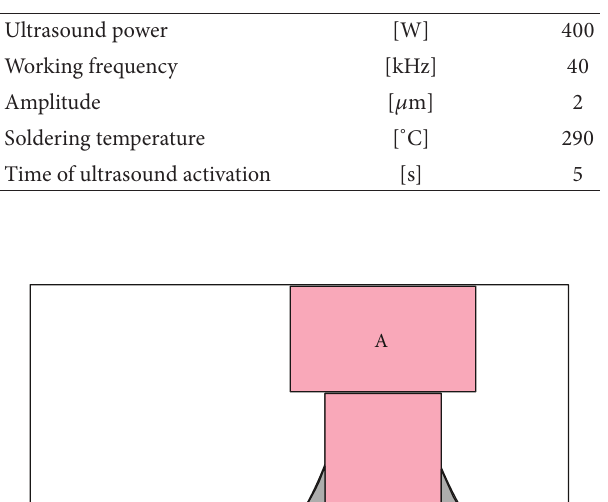
Table 1: Soldering parameters.